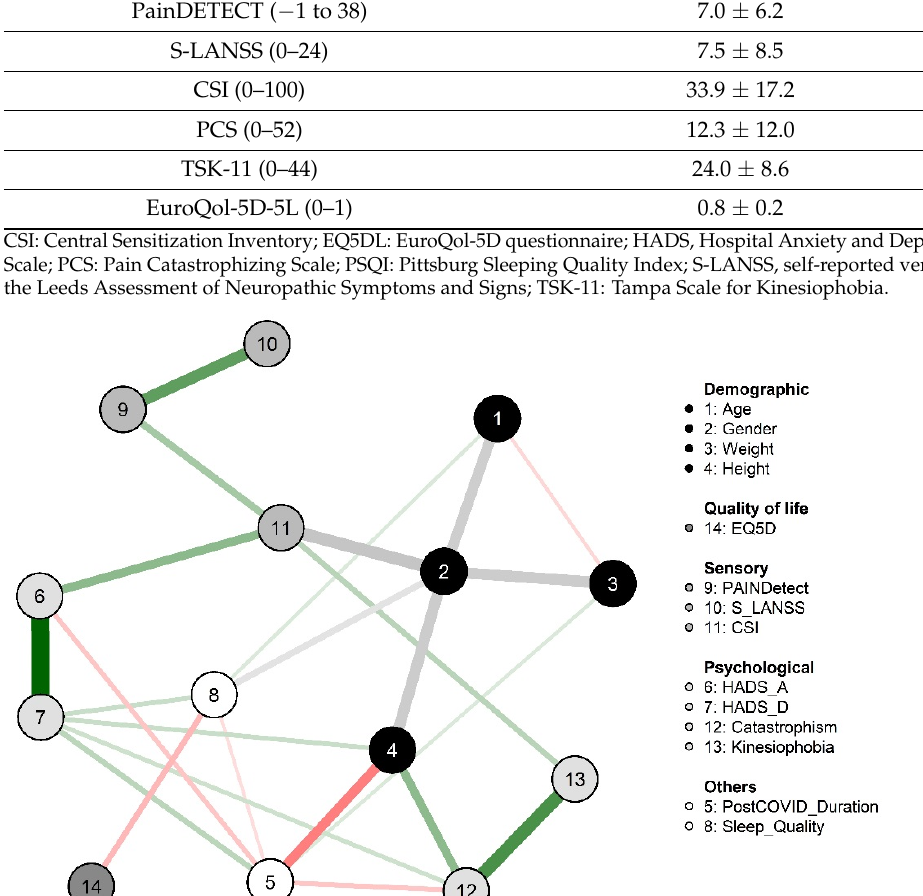
Figure 1. Network analysis of the association between demographic, sensory, psychological, quality of life and other measures in COVID-19 survivors with post-COVID pain. Edges represent connec- tions between two nodes and are interpreted as the existence of an association between two nodes, adjusted for all other nodes. Each edge in the network represents either positive regularized ad- justed associations (green edges) or negative regularized adjusted associations (red edges). The thickness and color saturation of an edge denotes its weight (the strength of the association between two nodes). CSI: Central Sensitization Inventory; EQ5DL: EuroQol-5D questionnaire; HADS, Hospi- tal Anxiety and Depression Scale; PCS: Pain Catastrophizing Scale; PSQI: Pittsburg Sleeping